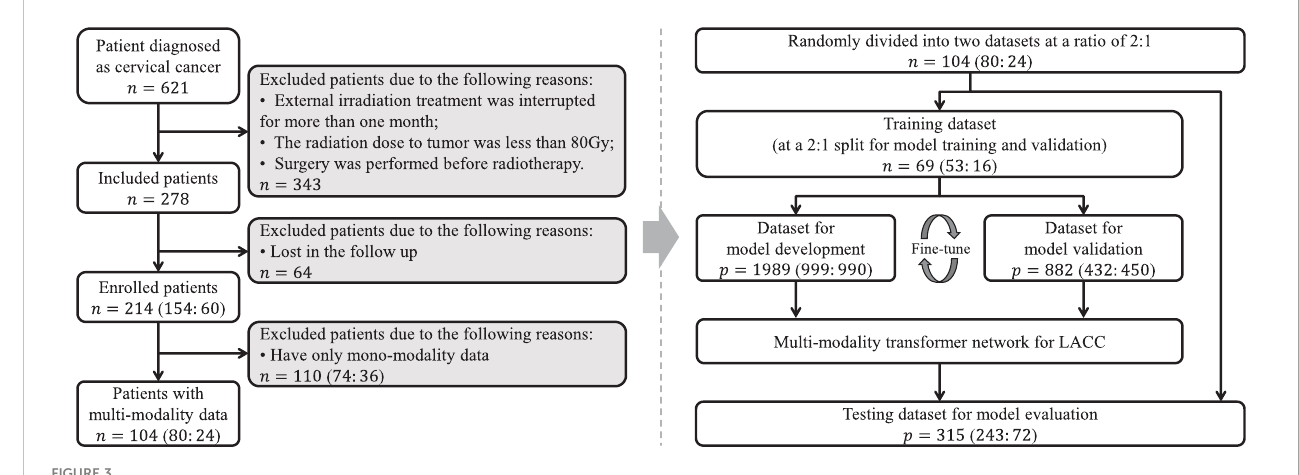
FIGURE 3 Patient inclusion and exclusion criteria, and the study fl ow chart.